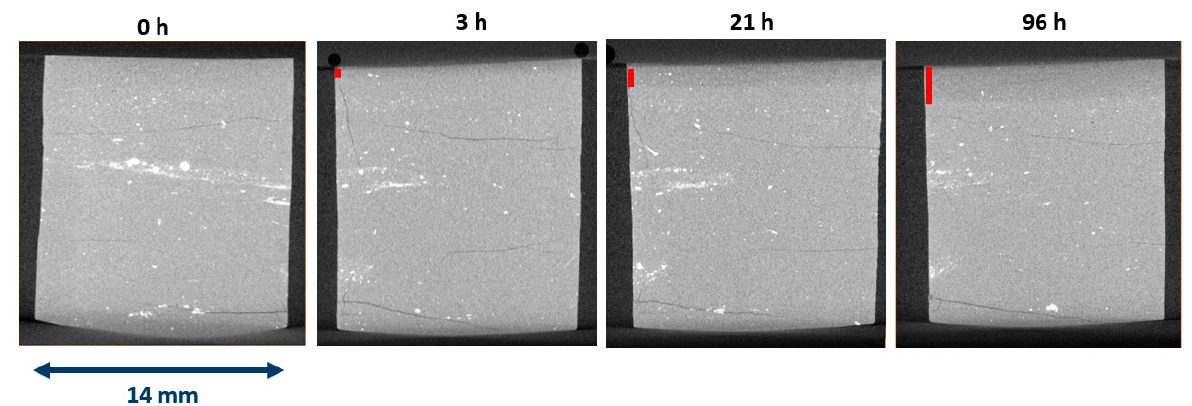
Figure 7. X-ray tomography cross-sections through the cylindrical shale sample A (in a parallel configuration where the surface exposed to 1 M HCl was parallel to the bedding plane) after different exposure times (0, 3, 21 and 96 h) indicating (red stripe) the progress of the etching process.